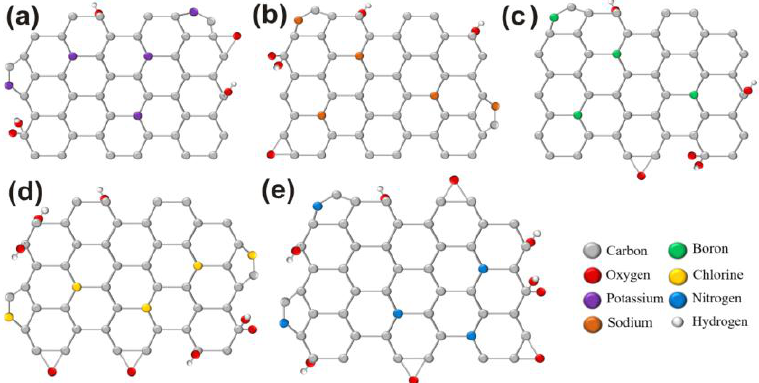
Figure 5. Schematic illustration for ( a ) K-GQDs; ( b ) Na-GQDs; ( c ) B-GQDs; ( d ) Cl-GQDs; and ( e ) N-GQDs showing the change in oxygen groups as a result of K, Na, B, Cl and N doping.